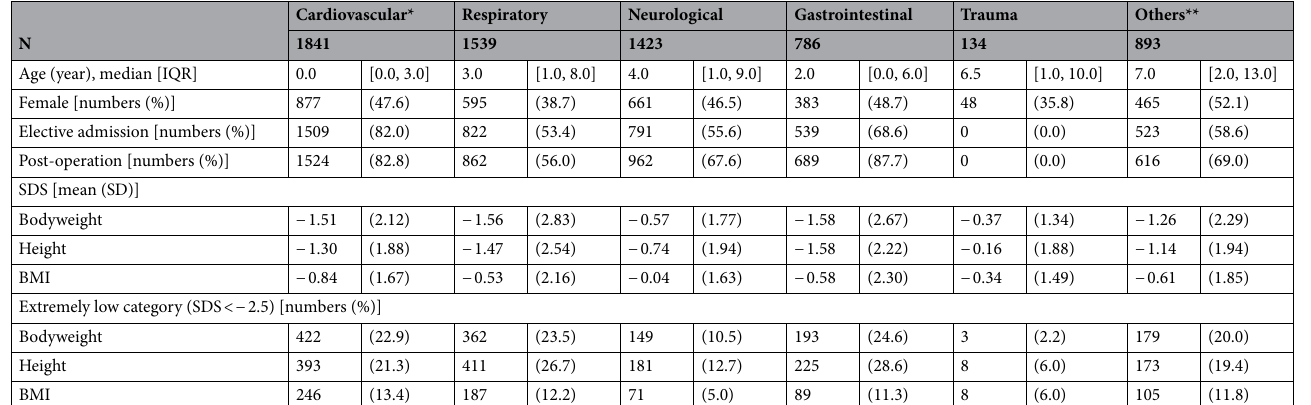
Table 2. Characteristics of study population including details of distribution across demographic and anthropometrical indices. BMI, body mass index; IQR, interquartile range; SD(S), standard deviation